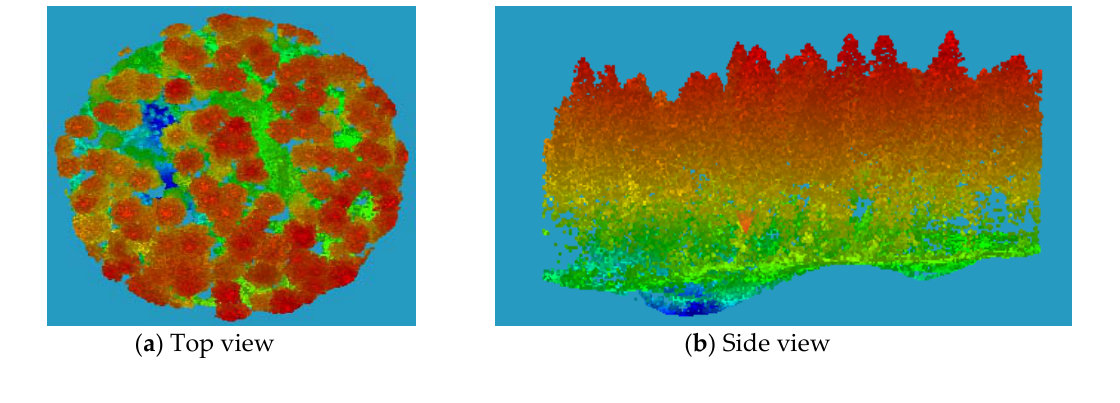
Figure 2. 3D view of ALS data.